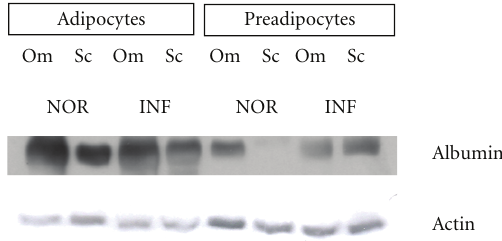
Figure 6: Negative relationship between Albumin circulating levels and Fat Mass. The Albumin circulating levels and Fat Mass were measured in 63 noninflamed patients. Correlation is significant at the 0.05 level (2-tailed). R = − 0 . 312.